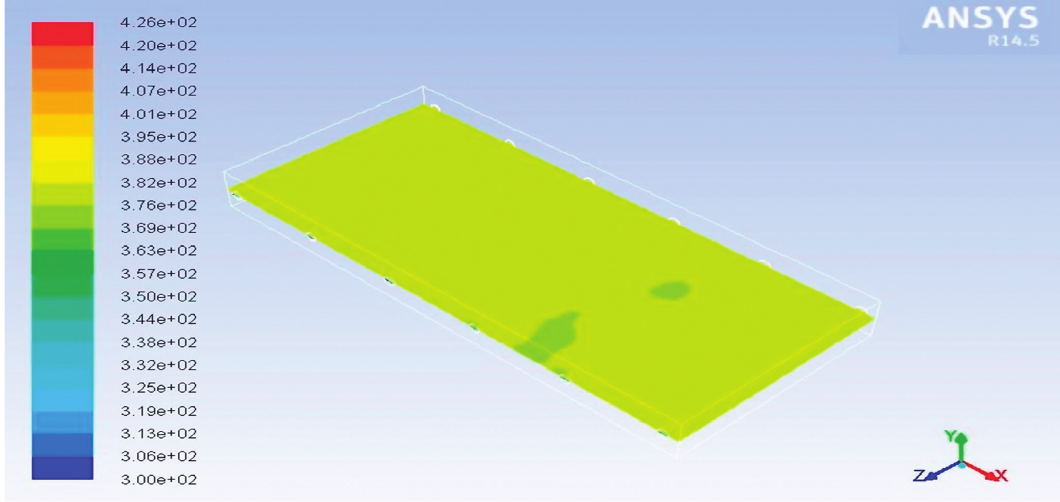
Figure 17: Red chillies in the solar dryer.